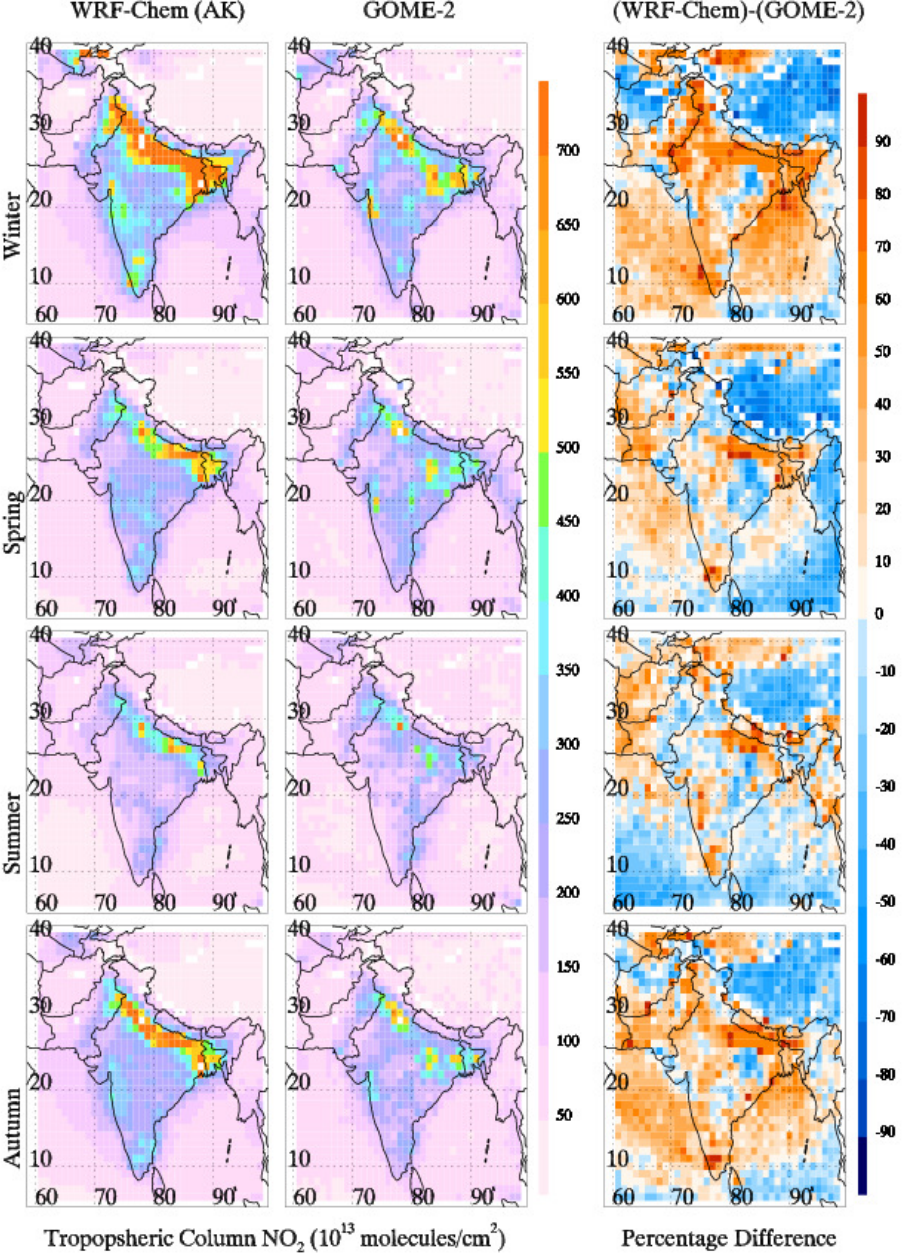
Fig. 15. Spatial distributions of WRF-Chem simulated and GOME-2 retrieved tropospheric column NO 2 during winter (DJF), spring (MAM), summer (JJA) and autumn (SON) 2008. Note that WRF-Chem profiles are smoothed with GOME-2 averaging kernel before comparison.